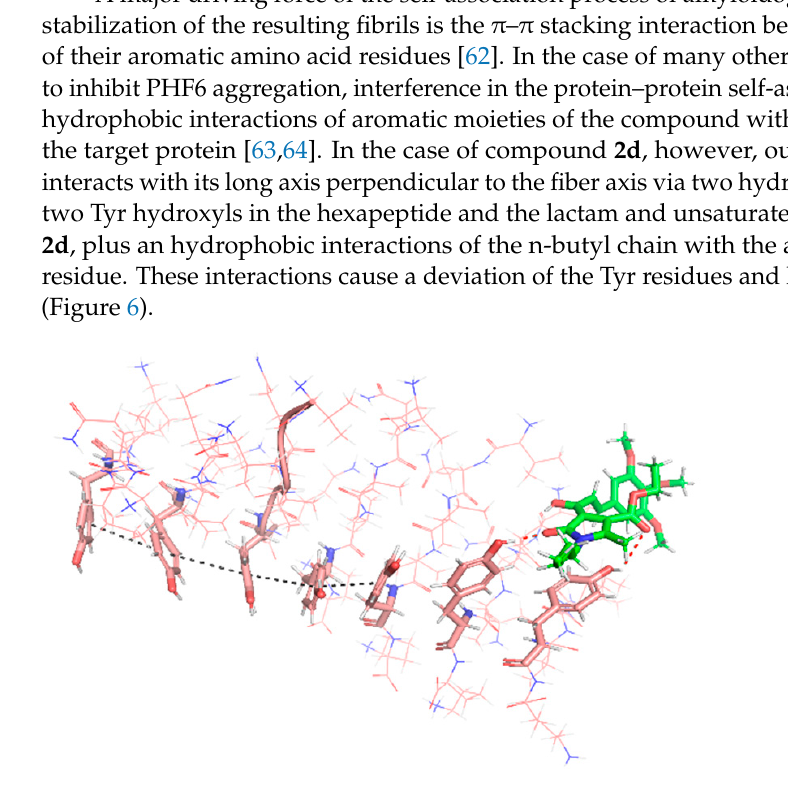
Figure 6. Compound 2d (green) established two hydrogen bonds with the phenolic moieties of Tyr (red dashed lines), disordering the oligomer (pink). The highly ordered structure of one strand, stabilized by aromatic π – π stacking interactions (black dashed line), can be observed on the left-hand side of the image, while the orientation of the Tyr residues on the right-hand side is altered by their interaction with 2d , hampering their stacking.